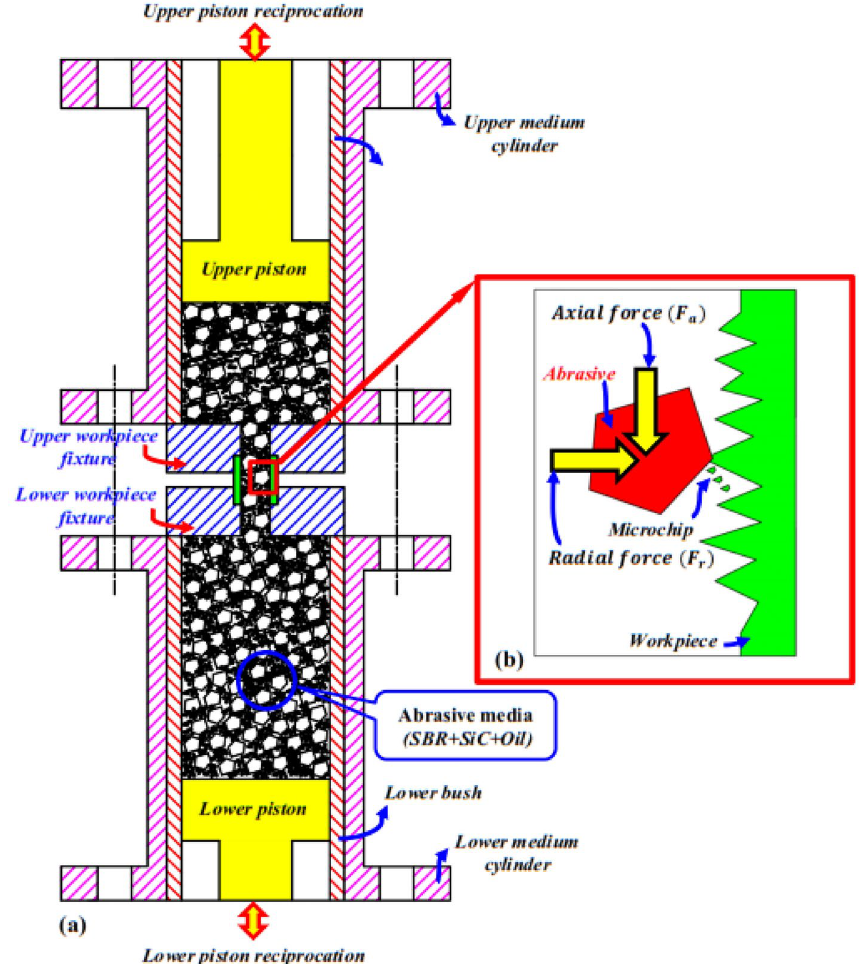
Fig. 1 a , b Schematic of the AFM process forces for machin- ing internal surface of